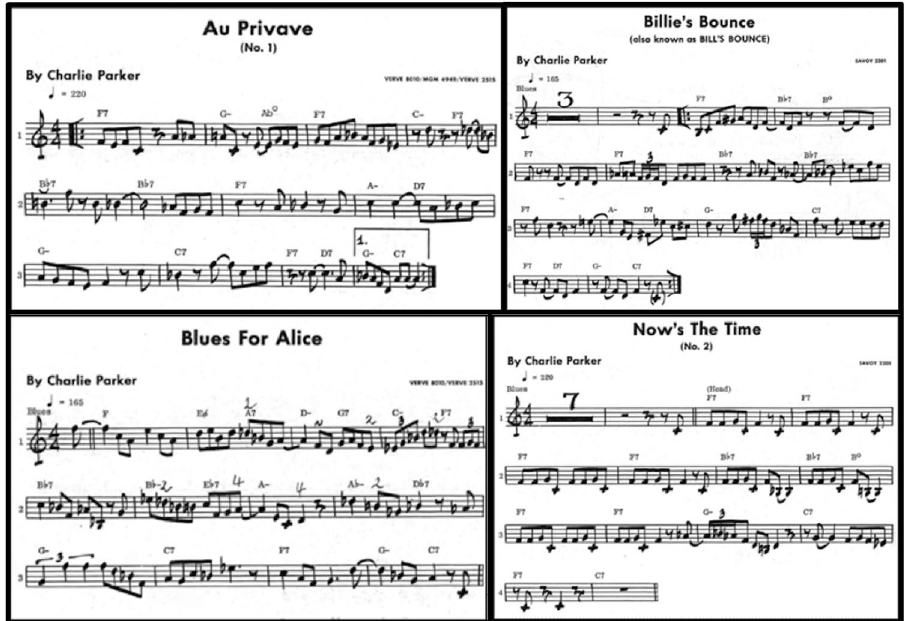
Figure 1. Participants learned one of these melodies at least 24 h before the scan.